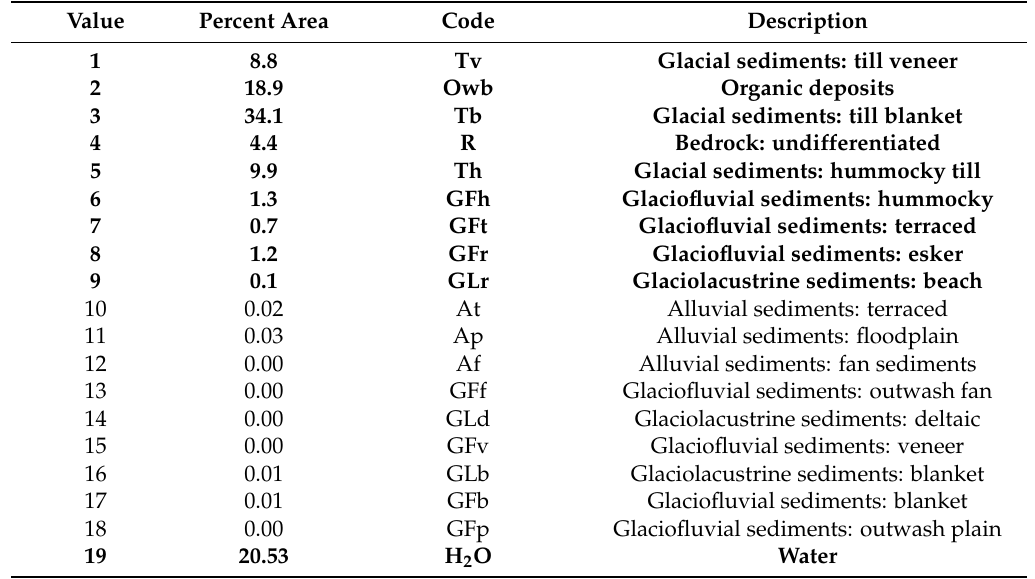
Table 1. Surficial geology units and distribution within an National Topographic System (NTS) map sheet